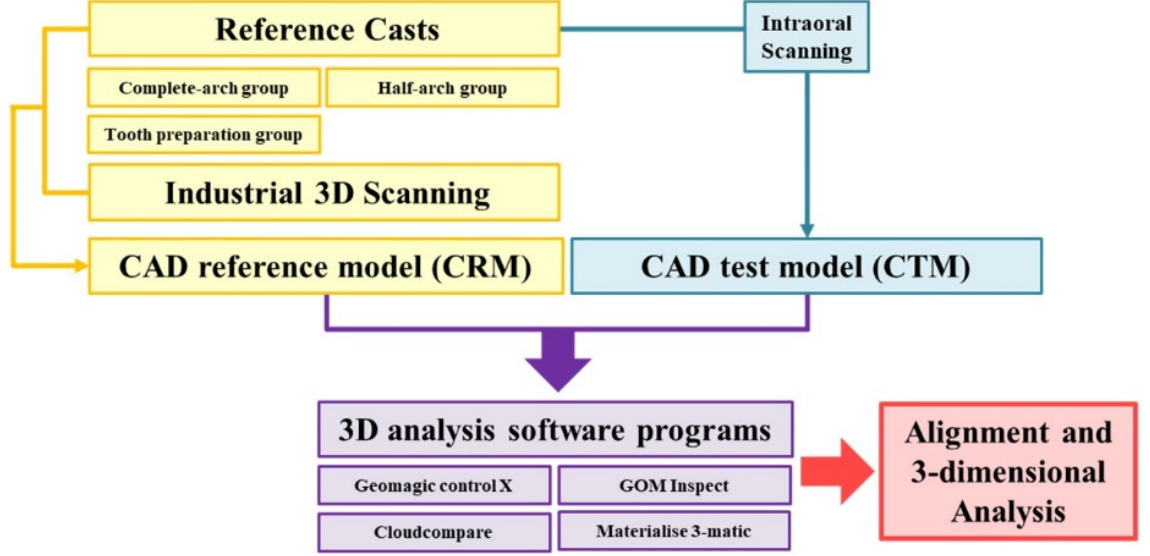
Figure 2. Experimental design.